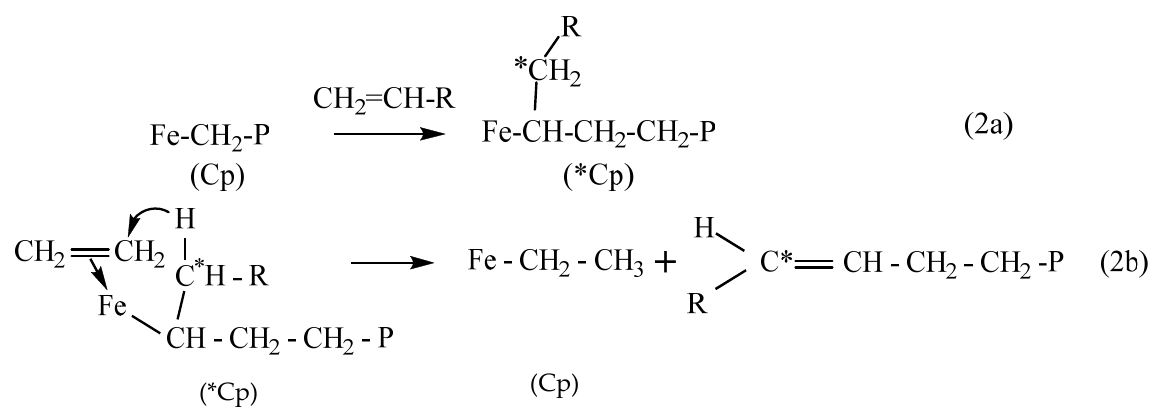
Scheme 1. Chain transfer reaction with formation of trans-vinylene groups in polymer produced with